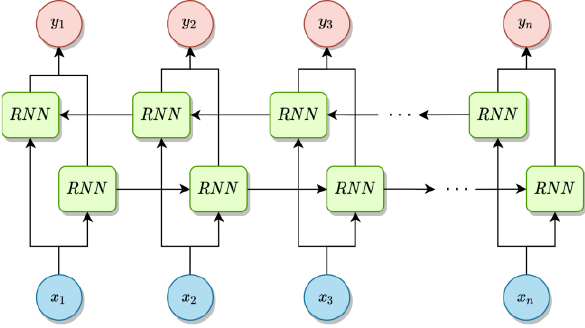
Figure 7. Bidirectional recurrent network.